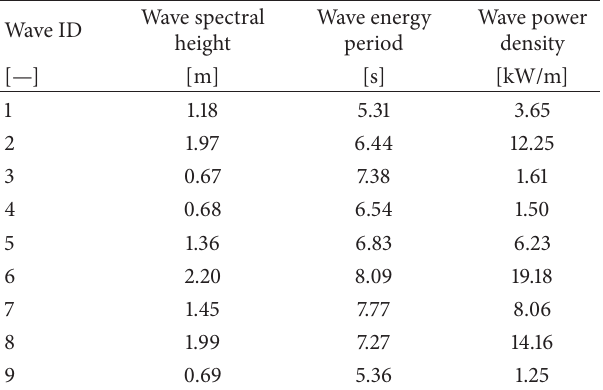
Table 2: Spectral properties of the chosen set of